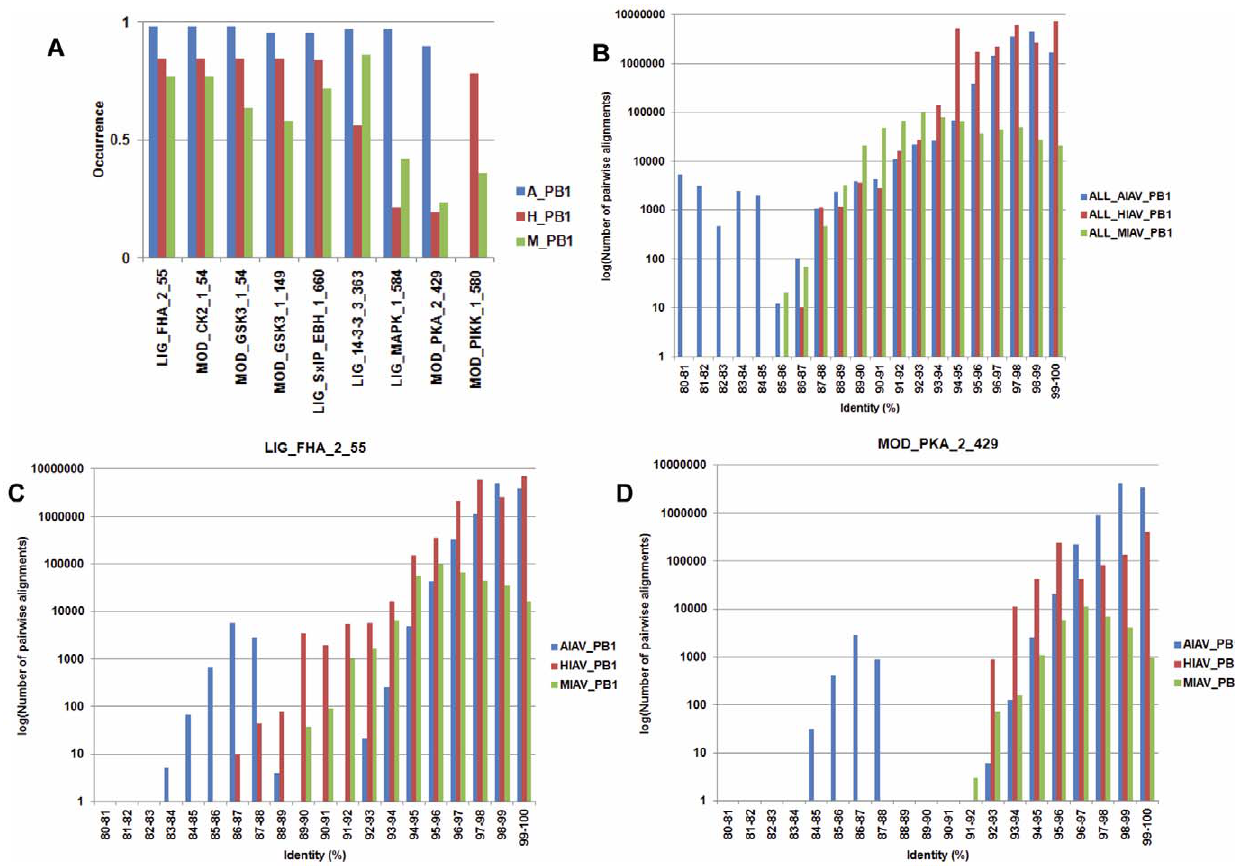
Figure 3. SLiMs from IAV PB1 proteins that have a differential occurrence in IAVs from different hosts. (A) 9 SLiMs that have a differential occurrence in IAV PB1 proteins from different hosts. A_PB1, H_PB1 and M_PB1 indicate the PB1 proteins from avian, human and IAV, respectively. The Y-axis indicates the occurrence of each identified SLiM. The X-axis indicates the name and position of each identified SLiM in the PB1 proteins. For example, ‘‘LIG_FHA_2’’ in ‘‘LIG_FHA_2_55’’ is the name of the SLiM, and 55 is the amino acid position where the SLiM starts. (B) The distribution of pairwise alignment identity of all PB1 protein sequences from avian, human and mammalian IAVs. (C) The distribution of pairwise alignment identity of PB1 protein sequences which harbor the SLiM LIG_FHA_2_55 from avian, human and mammalian IAVs. (D) The distribution of pairwise alignment identity of PB1 protein sequences which harbor the SLiM MOD_PKA_2_429 from avian, human and mammalian IAVs. For B, C and D, the X-axis indicates the number of pairwise alignments of IAV PB1 protein sequences. The Y-axis indicates the identity of pairwise alignment (the percentage of identical amino acids that are the same in both PB1 sequences). Blue: PB1 protein sequences from avian IAVs. Red: PB1 protein sequences from human IAVs. Green: PB1 protein sequences from mammalian